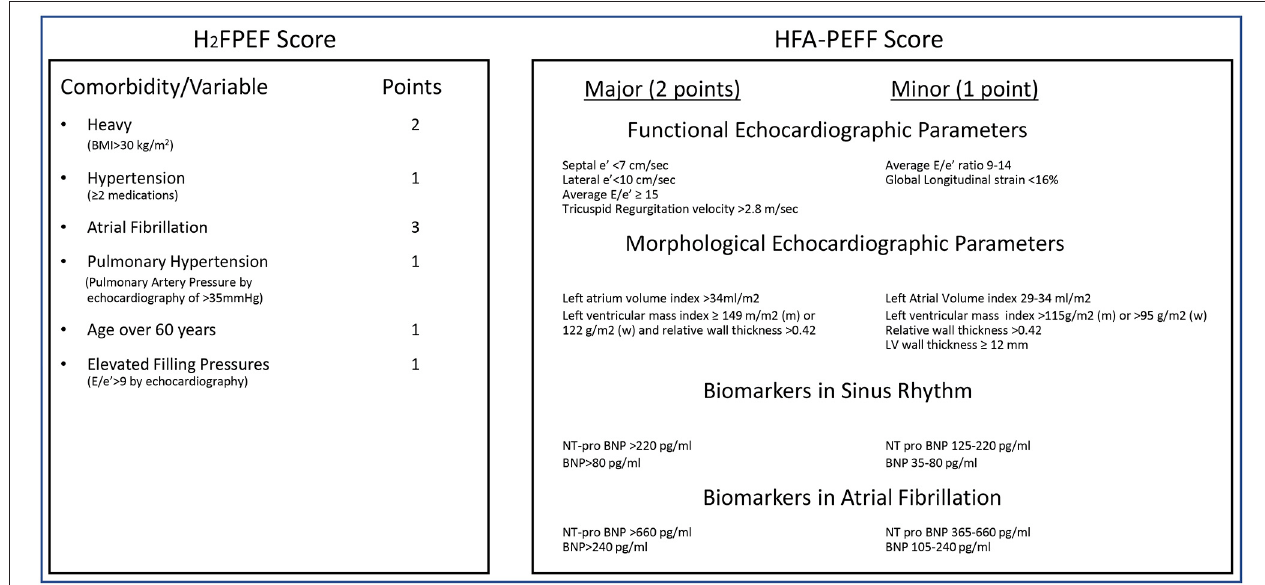
FIGURE 1 | Scoring algorithms for HFpEF diagnosis. H 2 FPEF score: Patient gets points based on presence of comorbidity/variable. Low probability of HFpEF (0–1 points), Intermediate Probability of HFpEF (2–5 points), High probability of HFpEF (6–9 points). HFA-PEFF score: Each category is assessed, and patients get points if meeting a major or minor criteria. Intermediate score (2–4 points), High score consistent with HFpEF ( ≥ 5